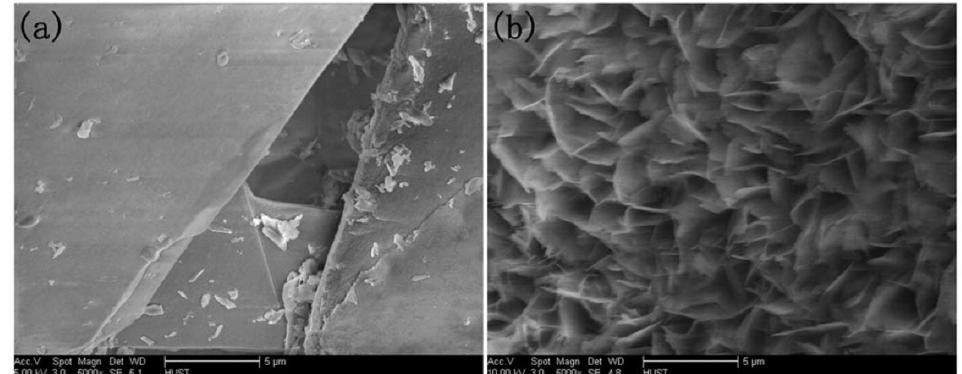
Figure 3. SEM image ( a ) without the addition of lipase enzyme, ( b ) with the addition of lipase enzyme. Reprinted from [21] with permission from the Royal Society of Chemistry. Copyright © The Royal Society of Chemistry. License Number: 1105113-1.